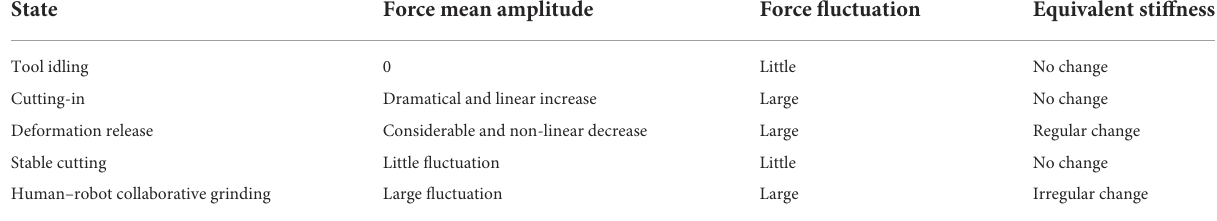
TABLE 2 Characteristics of each state. State Force mean amplitude Tool idling 0 No change Cutting-in Dramatical and linear increase Large No change Deformation release Considerable and non-linear decrease Large Regular